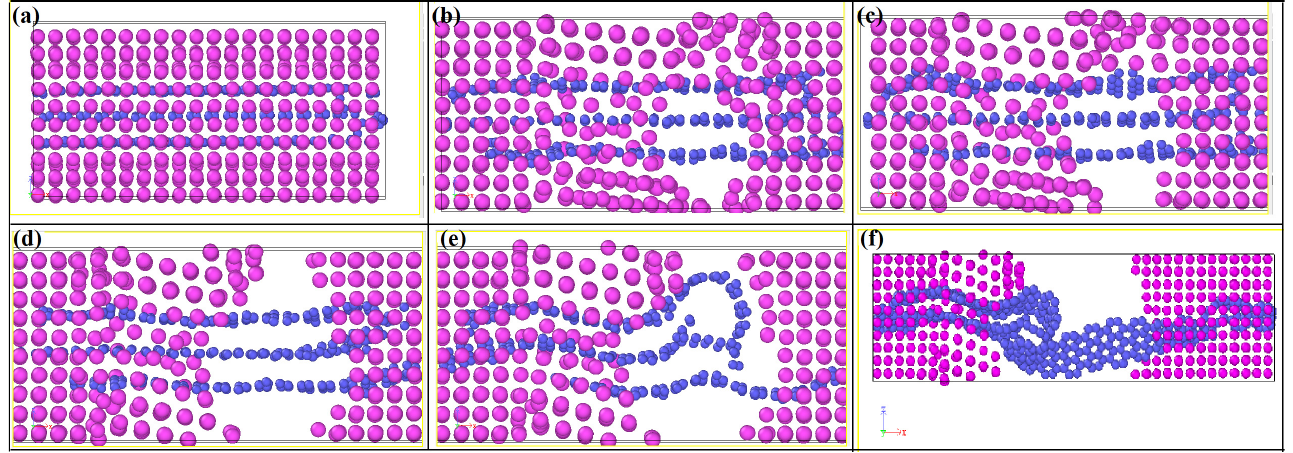
Figure 10. Schematic diagram of the tensile failure process of the three-layer graphene/aluminum composite. ( a – f ) represent the process of matrix cracking until material failure during